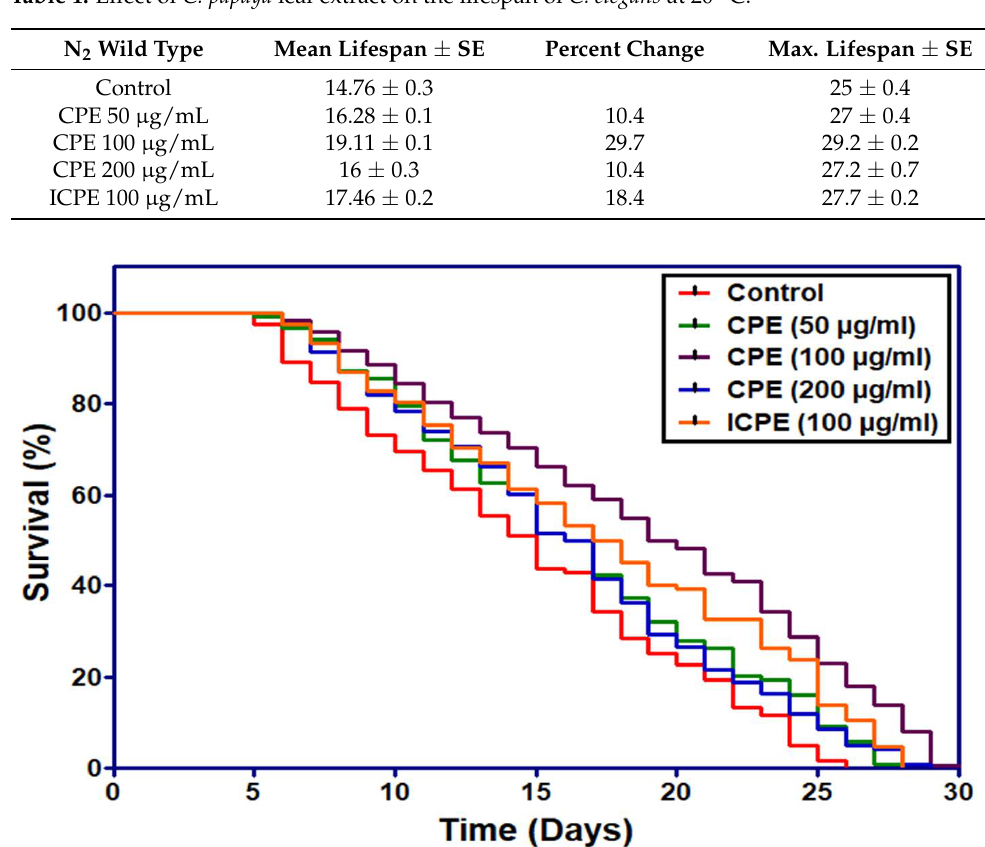
Table 1. Effect of C. papaya leaf extract on the lifespan of C. elegans at 20 °C.